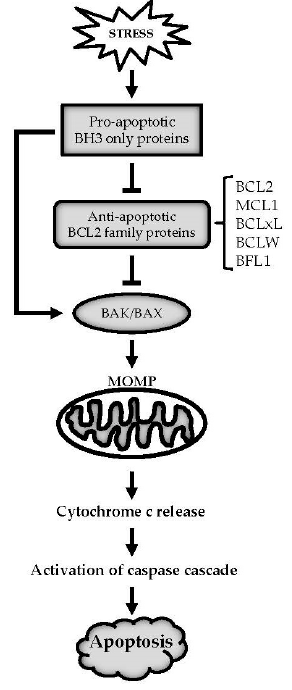
Figure 1. B cell lymphoma 2 (BCL2) family mediated intrinsic apoptosis signaling. Under